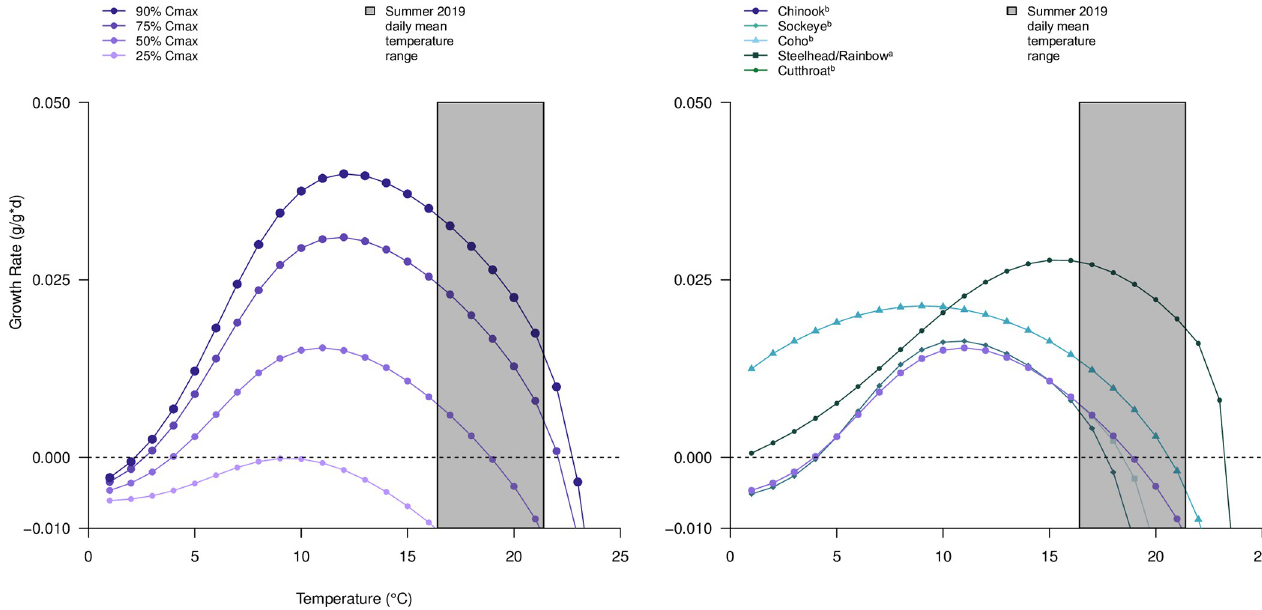
Fig 7. Modeled growth curve for juvenile Pacific salmon and trout. Growth curves are predicted for A) a five-gram juvenile Chinook salmon eating a low energy-dense diet of 3.0 KJ/g; and B) among salmonid species at 50% Cmax. Cmax is the percentage of theoretical maximum amount of prey a fish can eat given their body size (e.g., a 5.0 g fish can theoretically eat up.4 g of food a day, at a Cmax of 50% they consume 0.2 g). Species specific bioenergetic parameters as published in a [41] and/or b